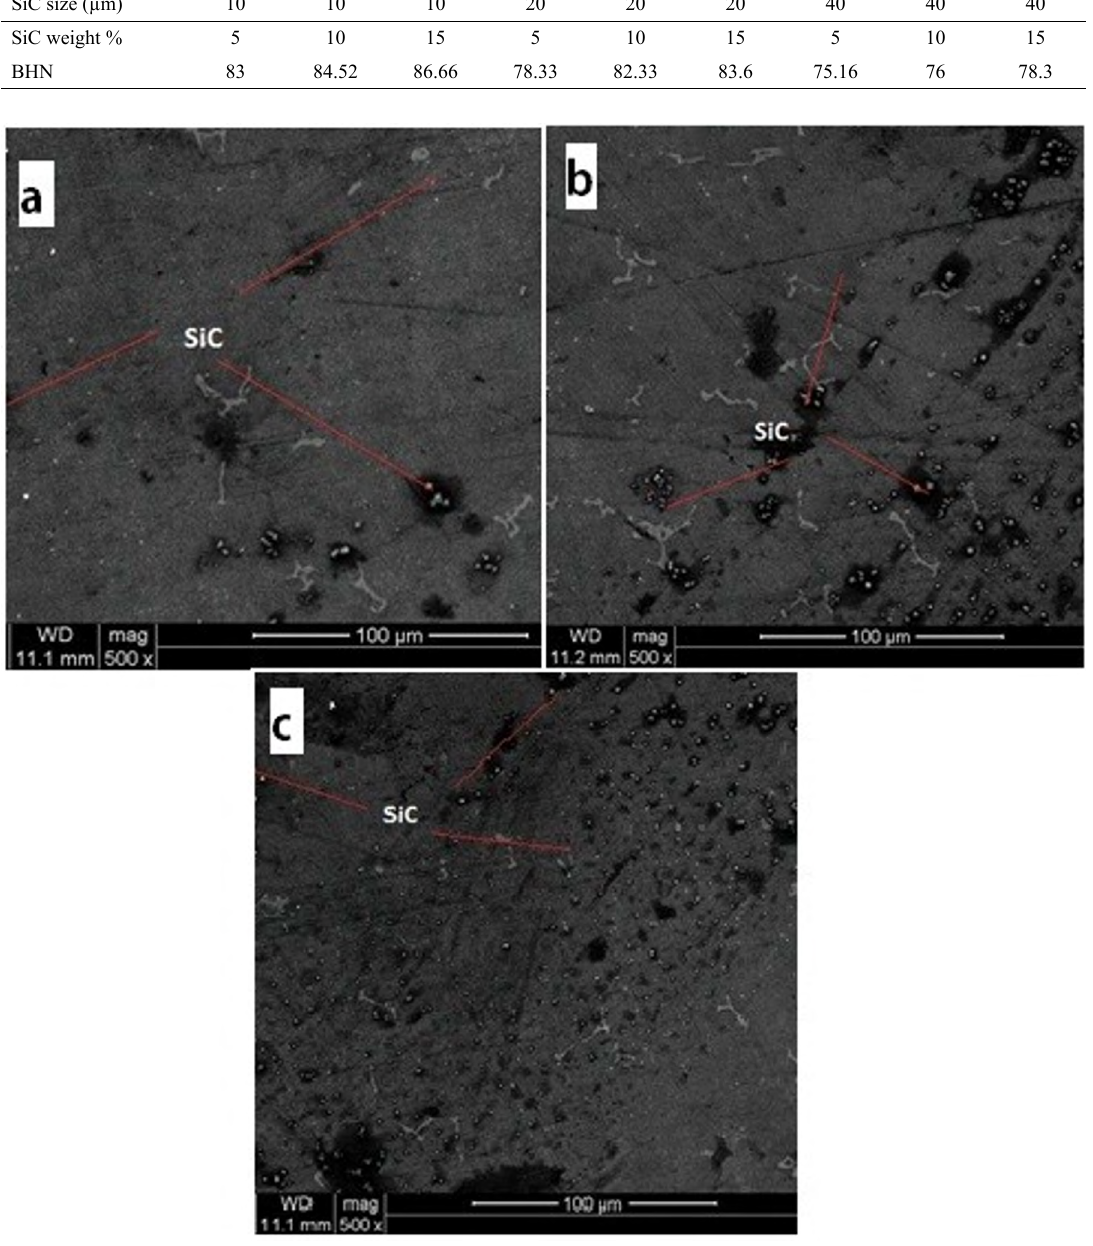
Figure 1. SEM images of Al5059/SiC/MoS 2 value of wear rate and co-efficient of friction. After each pins. Decrease in weight was measured using a weighing experiment, the disc and pins are cleaned with acetone to machine and wear rate and co-efficient of friction were eliminate impurities and wear debris attached on composite determined with the help of following